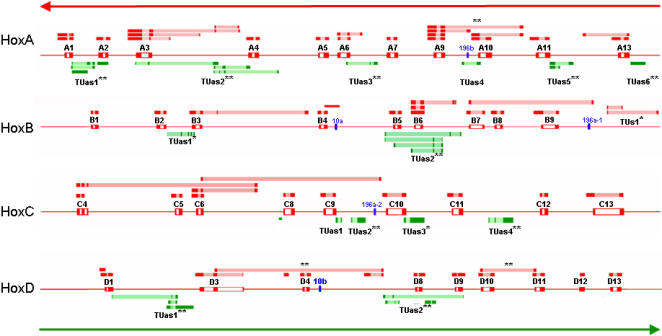
Synopsis of transcriptional activity in the Human Hox Clusters.Sense and antisense transcriptions are in red and green respectively. Dark and light shaded boxes represent exon and intron. Mir genes are in blue. The three long transcripts presenting a murine homolog with a conserved exon-exon boundary are headed by **. The 13 TUs (12 antisense and one sense) located at similar position in human and mouse are denoted by an asterisk (*) while the 10 TUs showing conservation are depicted with